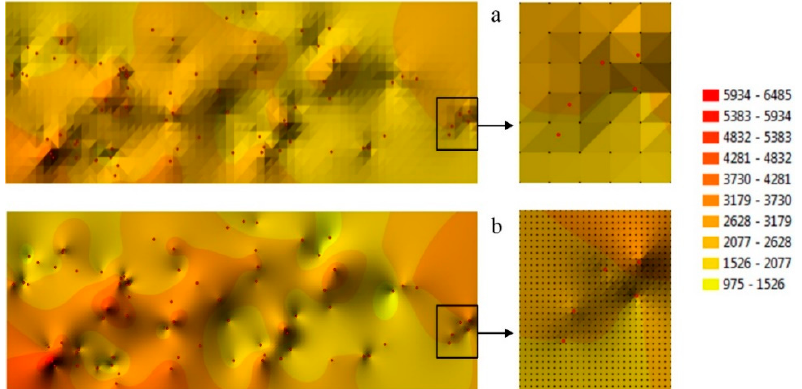
Figure 3. GRID surface generated based on interpolation nodes: ( a ) distribution of interpolation nodes; ( b ) interpolated surface visualized in 2D; ( c ) interpolated surface visualized in 3D. Source: own elaboration.